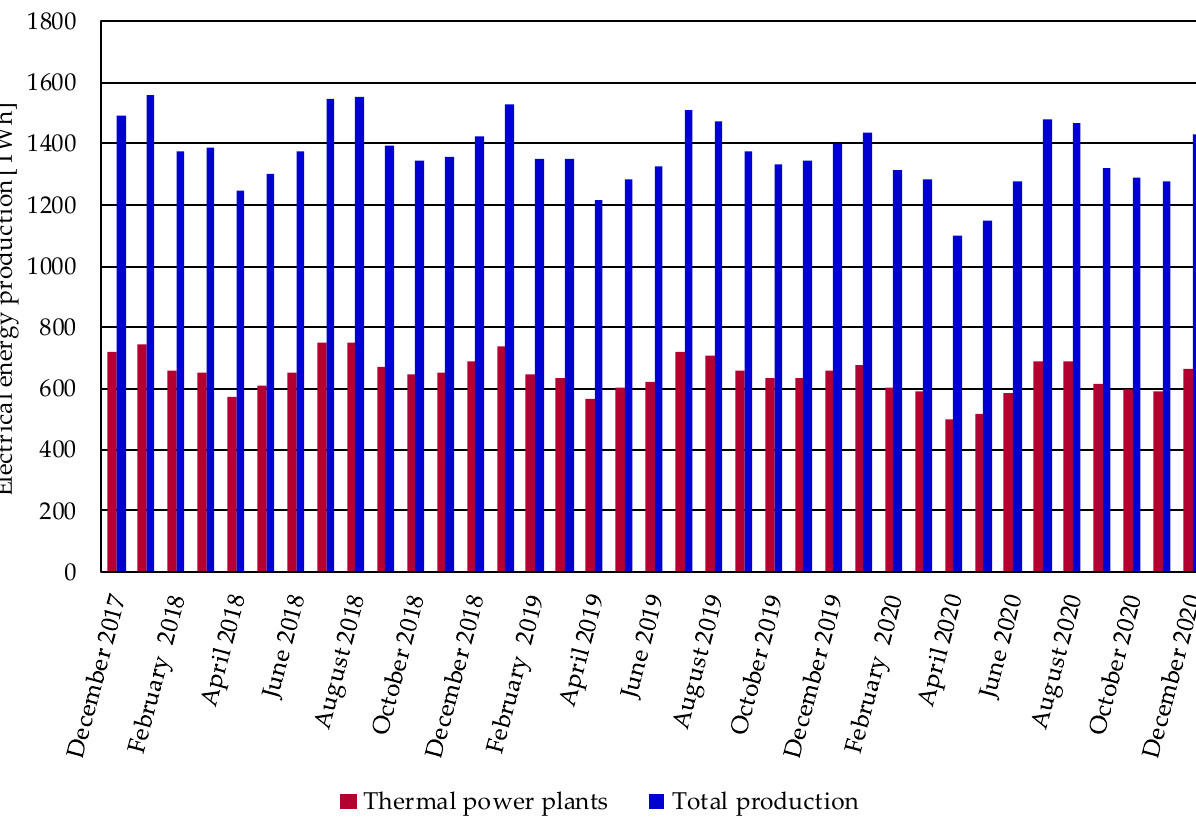
Figure 1. A report of International Energy Agency [2] into monthly electricity production.